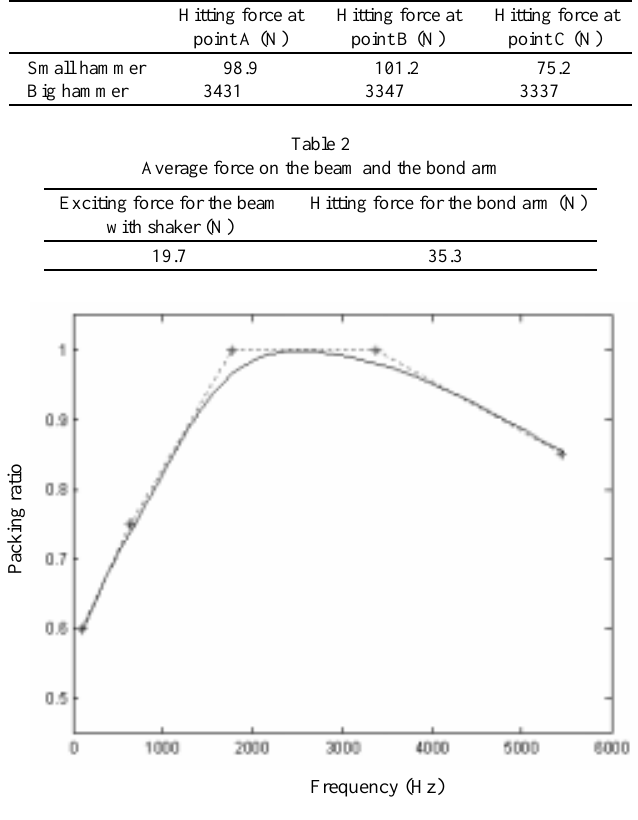
Table 1 Average hitting forces for the bond head stand with small and big hammers